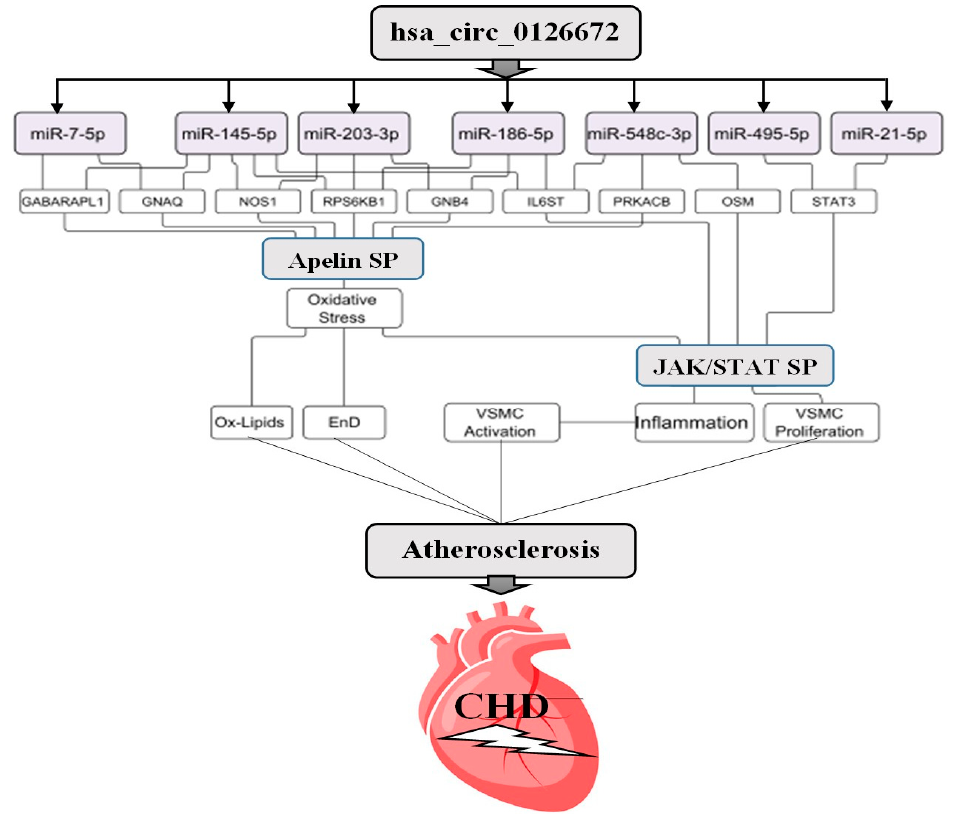
Figure 8. Proposed summary model indicating the role of hsa_circ_0126672 in the pathogenesis of CHD. CHD: coronary heart disease, EnD: endothelial dysfunction, SP: signaling pathway, ox-lipids: oxidized lipid, VSMCs: vascular smooth muscle cells